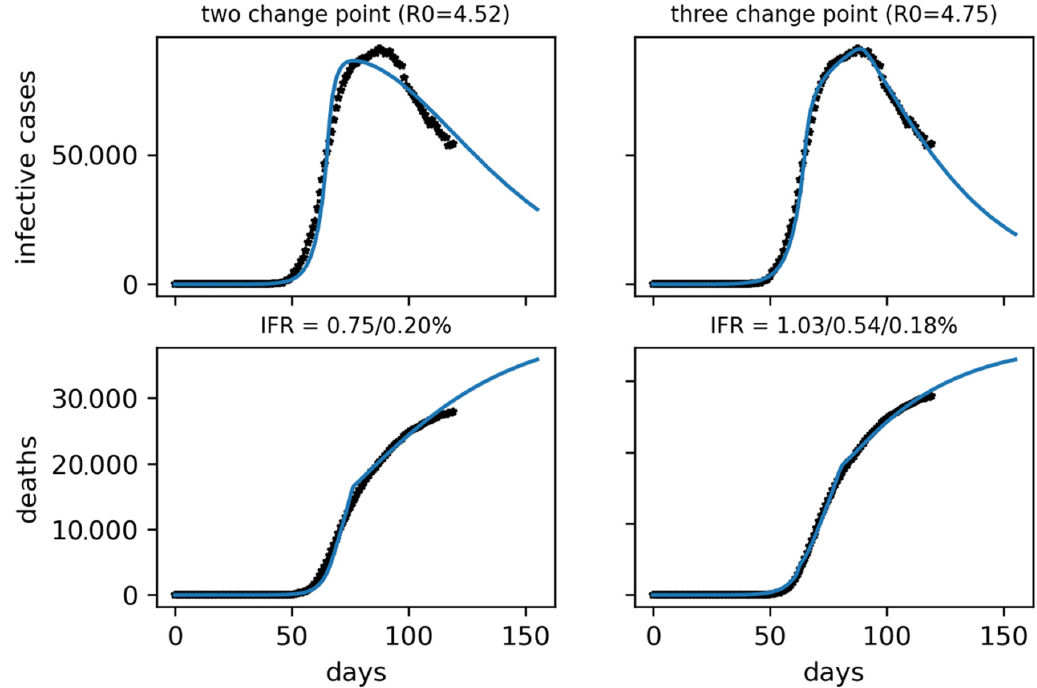
Figure 13. Unlike with Korea, the Spain curve does not fit well with a single or two change points in a SEIRD model.